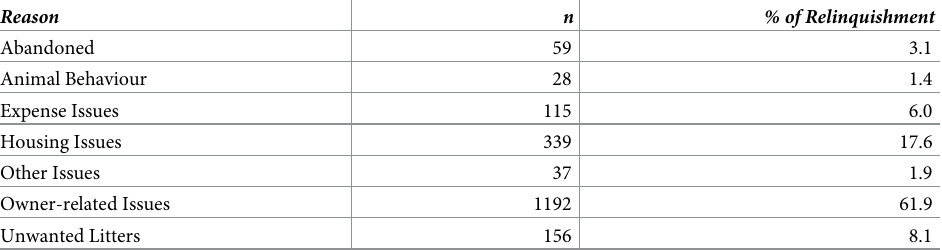
Table 3. Reasons given for relinquishment (N = 1,926).